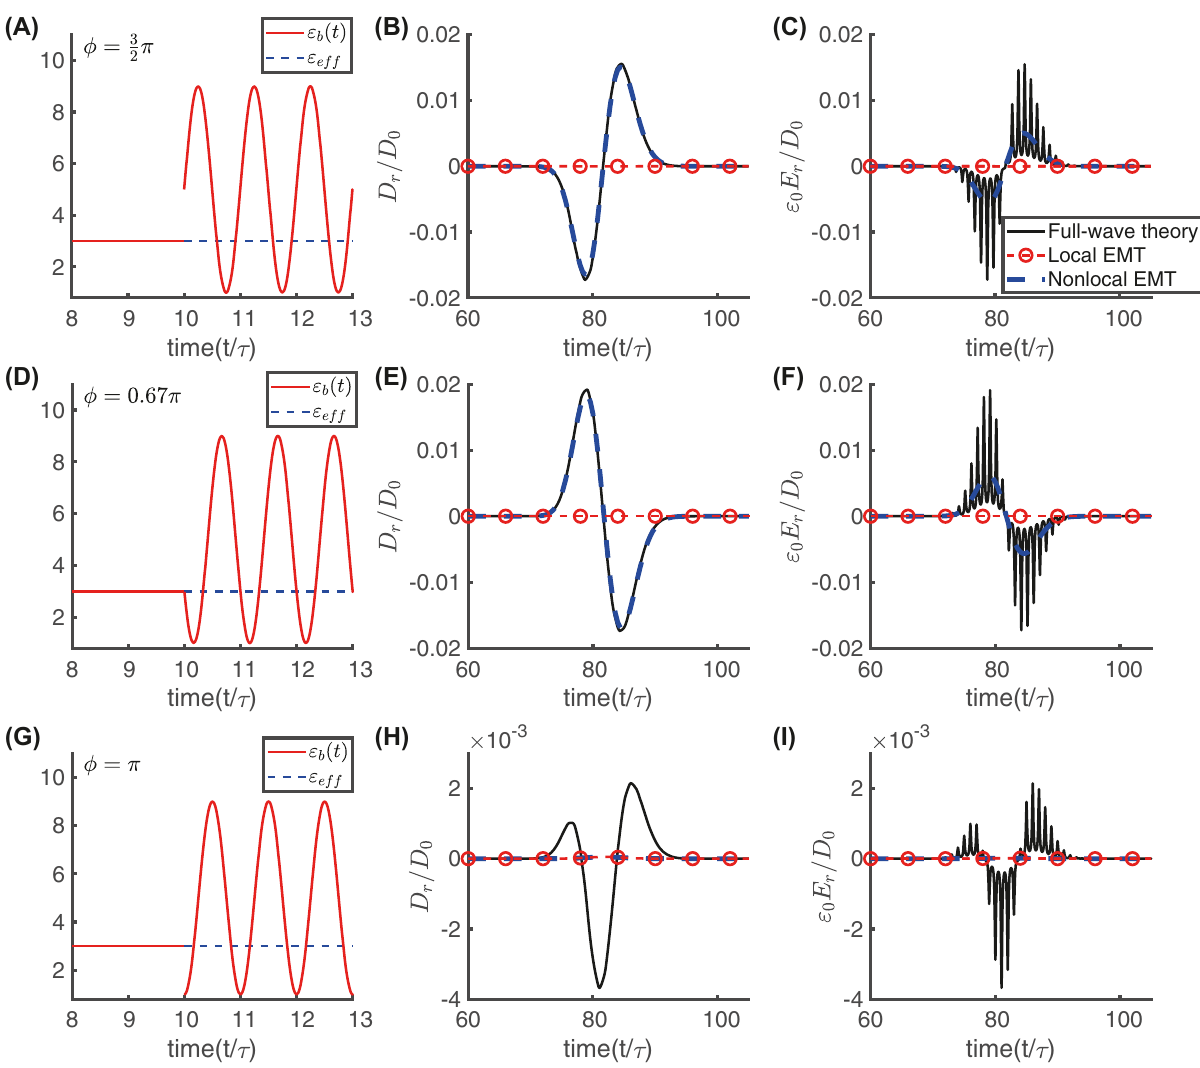
Figure 7: Comparison between the backward wavepacket profiles predicted by full-wave simulations, local and non-local EMTs. The considered temporal dielectric profiles ensuring the impedance-matching conditions [i.e., the configuration described by Eqs. (11) and (10), = 3, t = 10 𝜏 , Δ = 0 . 8, and 𝜀 = 5] is plotted with 𝜙 = 3 𝜋 ∕ 2 (panel (A)), 𝜙 = 0 . 67 𝜋 (panel (D)), and 𝜙 = 𝜋 (panel (G)). Panels (B), (E), with 𝜀 1 0 ∕ D for the backward pulses. Panels (C), (F), and (I) show the and (H) show the corresponding normalized electric inductions D r 0 ∕ D . All temporal profiles are evaluated at z = − 30 c 𝜏 corresponding normalized electric fields 𝜀 0 E r 0